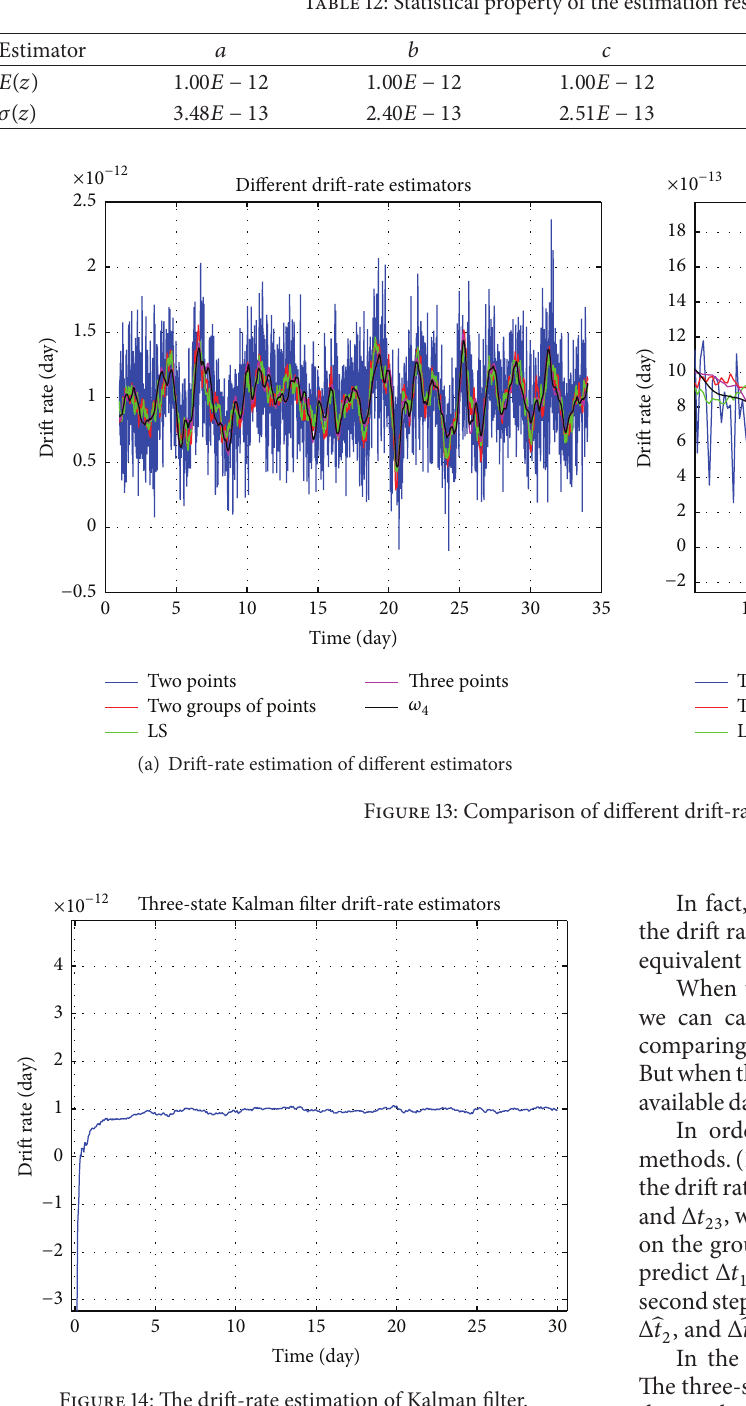
Figure 14: The drift-rate estimation of Kalman